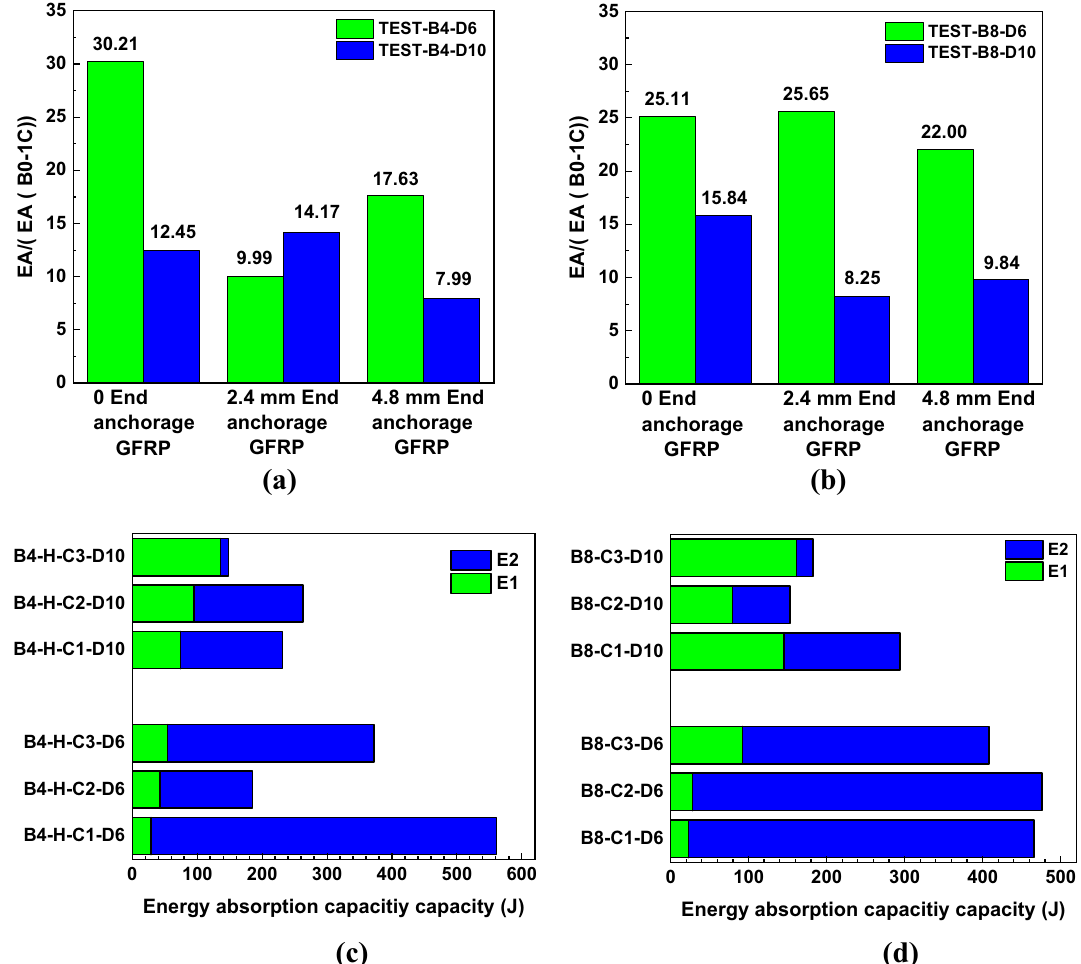
Fig. 14 Energy absorption versus bolt diameter and end-anchorage thickness: a , b normalized values; c , d detail of pre (E1) and post (E2)-energy